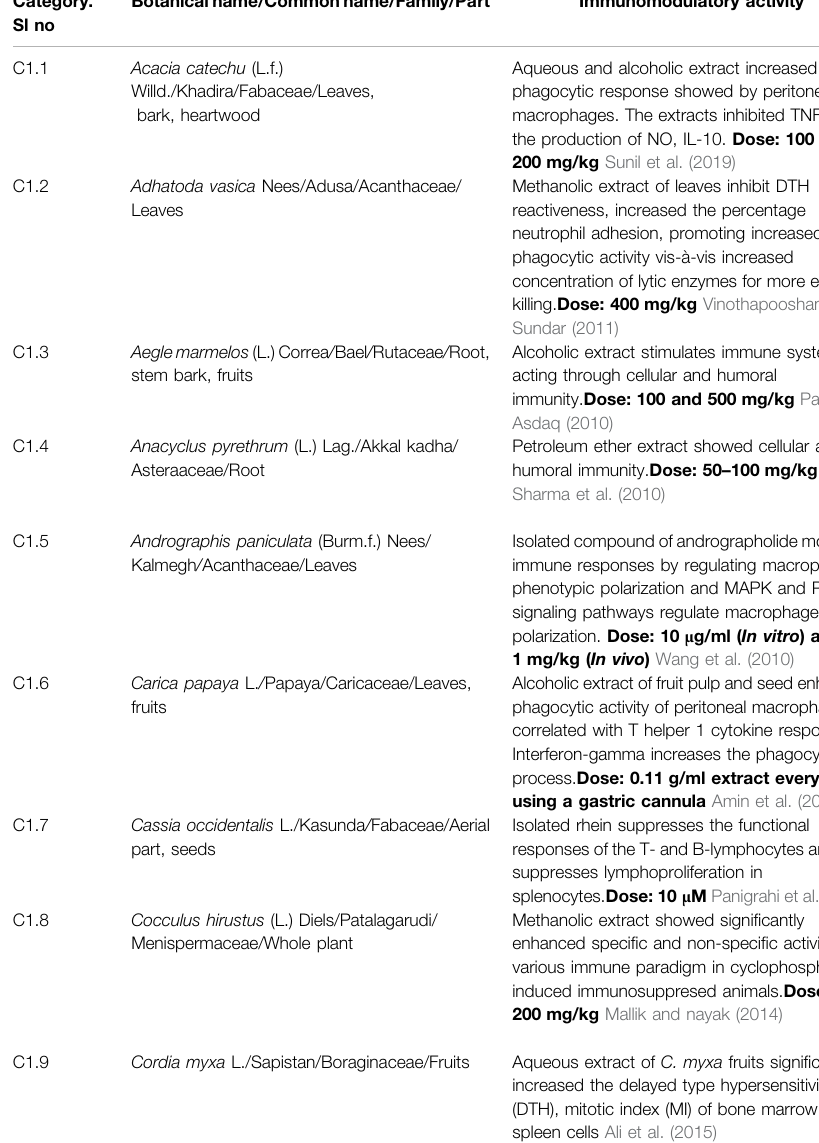
TABLE 5 | List of Indian Medicinal Plants/AYUSH drugs with proven immunomodulatory, antiviral and anti-allergic/anti-in fl ammatory/anti-asthmatic activity having potential for exploring against COVID 19 categorized for prioritization on the basis of their earlier reports. Category. Sl